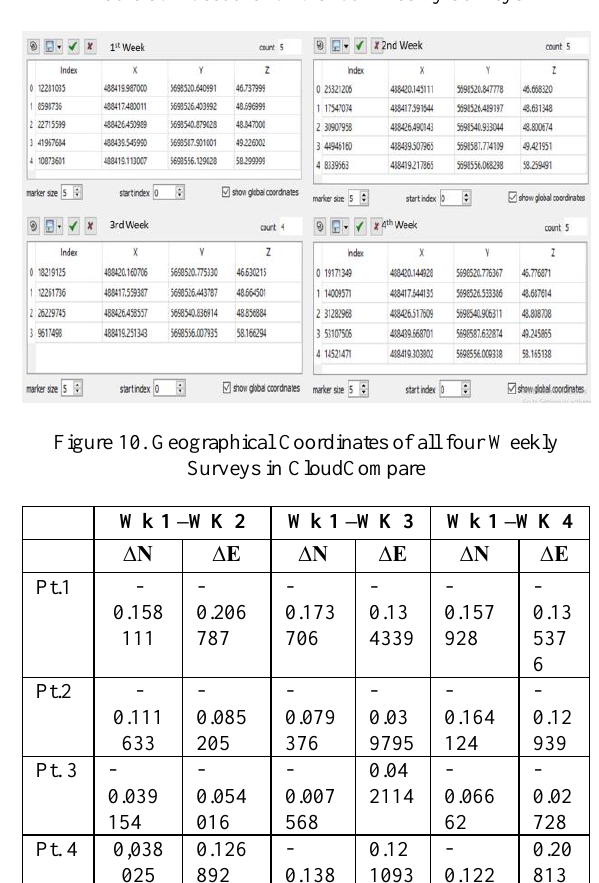
Table 3. Procedure for the four Weekly Surveys